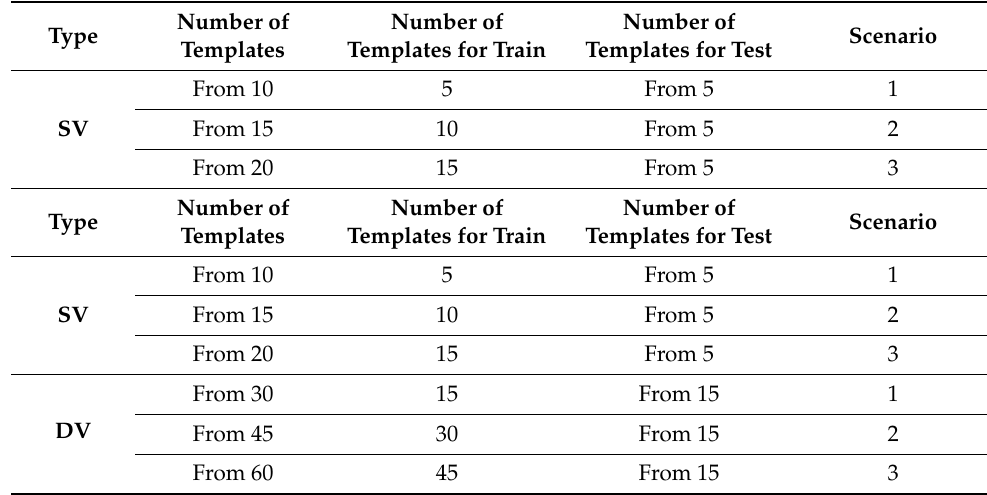
Table 4. Details of the experimental scenarios.